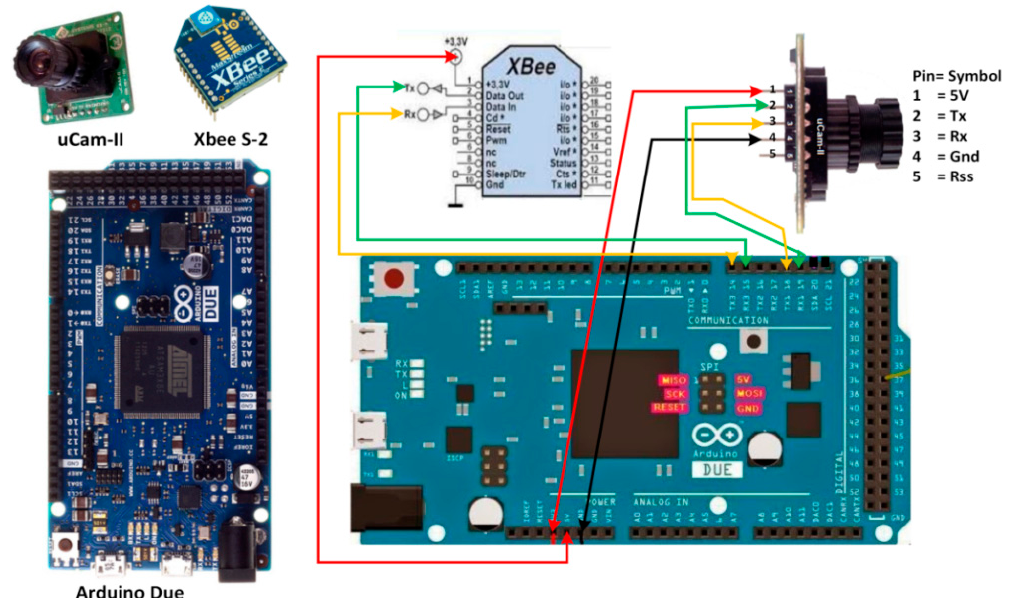
Figure 2. Standalone visual node built using Arduino Due, uCAM-II, and XBee [31].